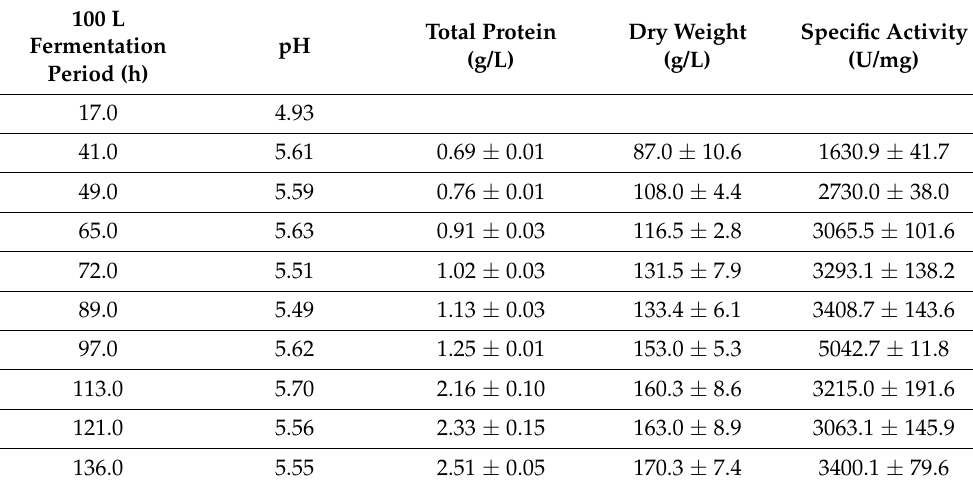
Table 2. Yield and specific activity during 100 L